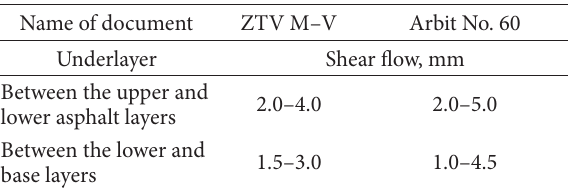
Table 1. The recommended values for the shear flow of asphalt layers Name of